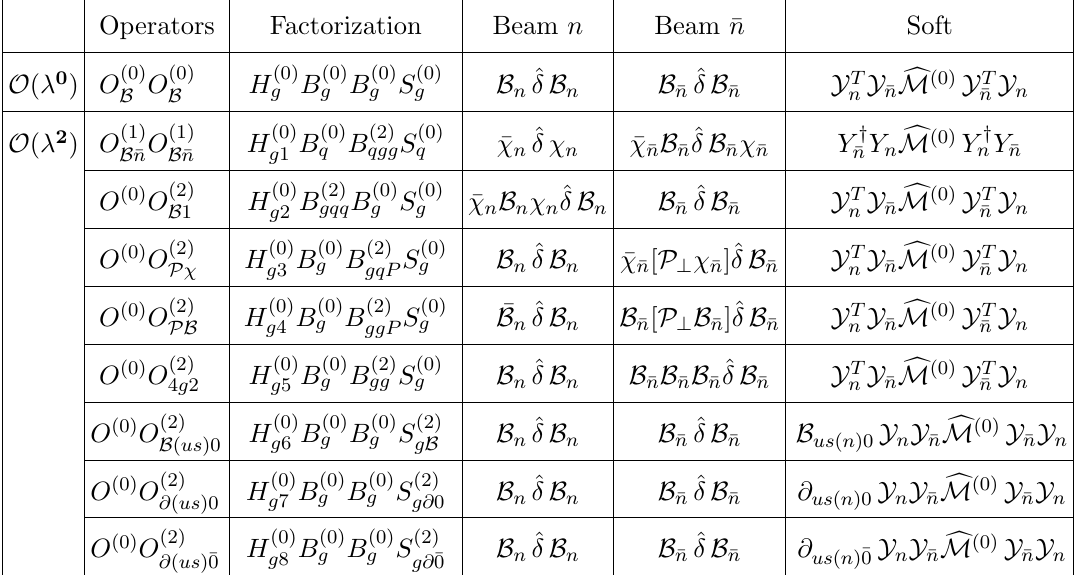
Table 4 . Subleading beam and soft functions arising from products of hard scattering operators in the factorization of Higgs with a jet veto, and their (cid:12)eld content. Helicity and color structures have been suppressed. We have not included products of operators whose beam and soft functions are identical to those shown by charge conjugation or n $ (cid:22) n